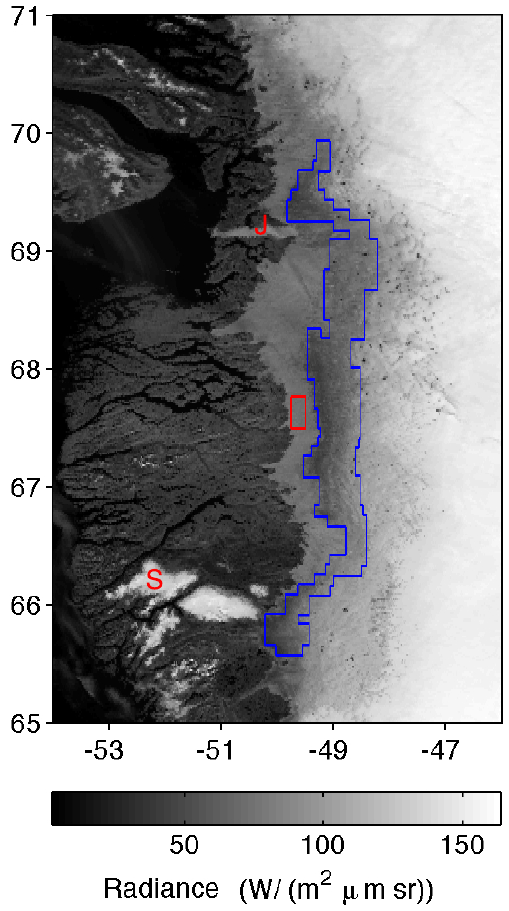
Fig. 1. MODIS image from 9 August 2007, band 2 (841–876nm), with the appearance of the dark region indicated with a blue contour. S is Sukkertoppen Iskappe and J is Jakobshavn Isbrae. The red con- tour indicates the reference area as described in Sect. 4. (Latitudes and longitudes along the axes).